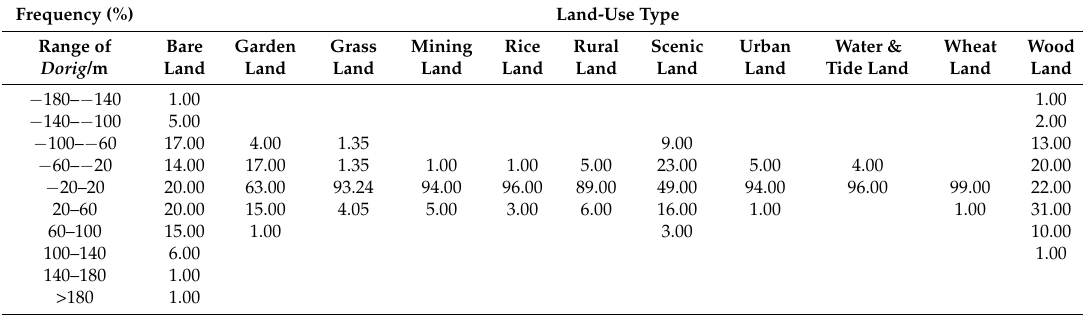
Table 1. Frequency distribution of Dorig (the difference between the original GDEM2 and the first sample